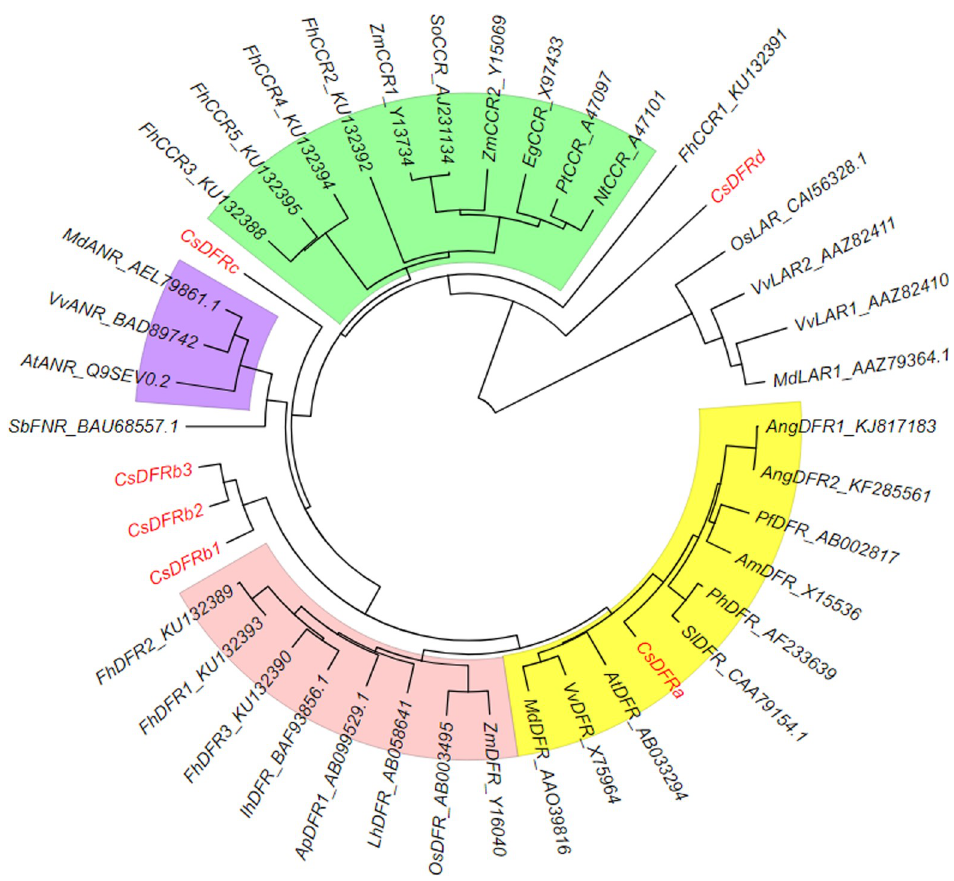
Fig 4. Phylogenetic tree of putative CsDFR proteins with other similar proteins. Protein names and accession numbers are marked on each node, according to Li et al. [16]. Yellow: Dicotyledon DFR; Red: Monocotyledon DFR; Blue: ANR (anthocyanidin reductase); Green: CCR (cinnamoyl-CoA reductase).